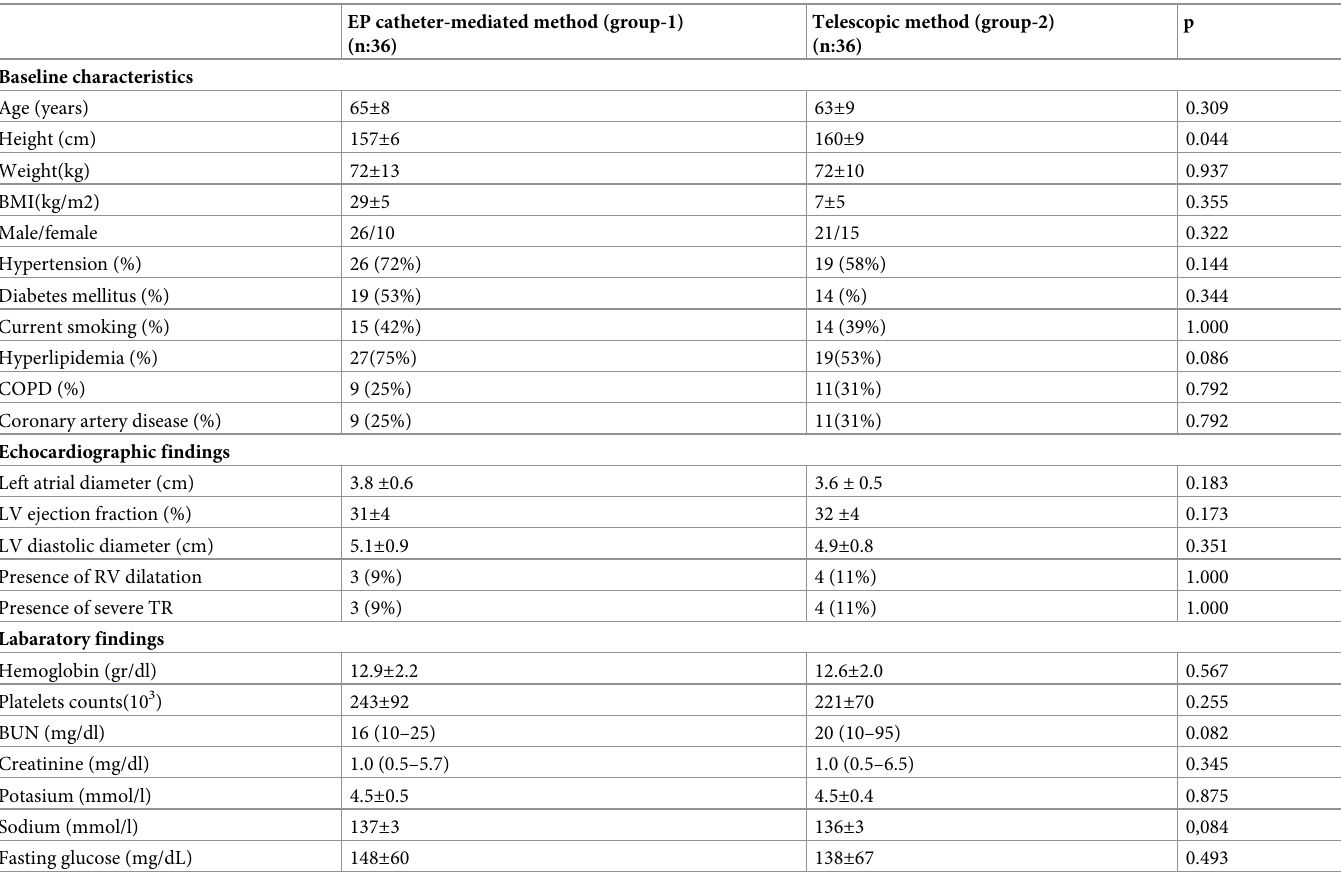
Table 1. Baseline characteristics of study patients.